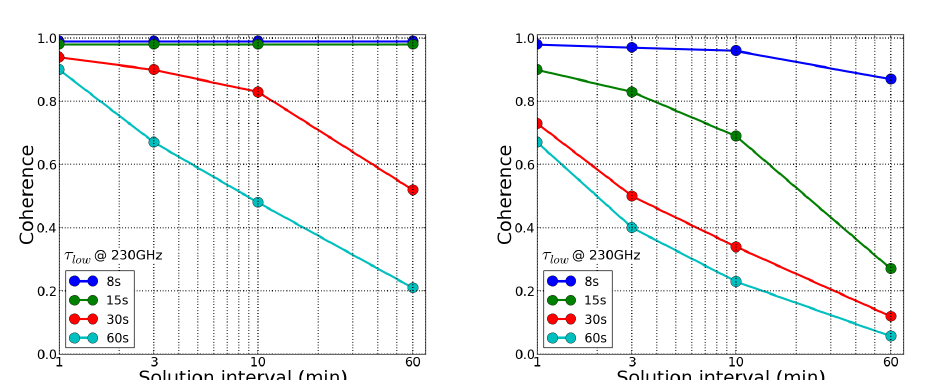
Figure 2. Expectations for FPT Coherence for the 340 GHz band under Very Good ( Left ) and Good ( Right ) weather conditions, after calibration with simultaneous 230 GHz band observations, for a range of integration times up to 60 min. Different colors are for different calibration timescales at 230 GHz (i.e., τ low ) as listed in the inset: 8 s (dark blue), 15 s (green), 30 s (red) and 60 s (cyan). In Very Good weather τ low ≤ 15 s results in sustained high coherence ( (cid:29) 0.9); longer τ low timescales leads to degradation of the coherence, dropping to a coherence of 0.9 at 340 GHz for solution intervals up to 3 min or 0.8 for 10 min solutions intervals. This degradation is caused by the non integer frequency ratio in these simulations. Under G weather conditions with τ low ∼ 8 s we achieve coherence of 0.9 at 340 GHz up to an